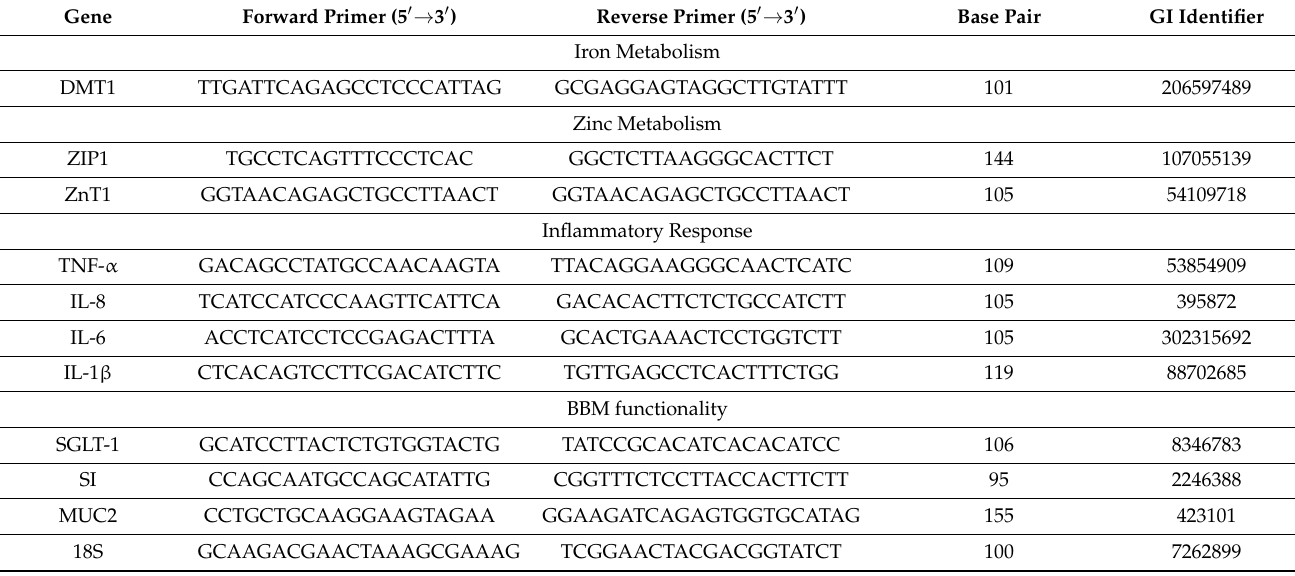
Table 1. Real-time polymerase chain reaction (RT-PCR) primer